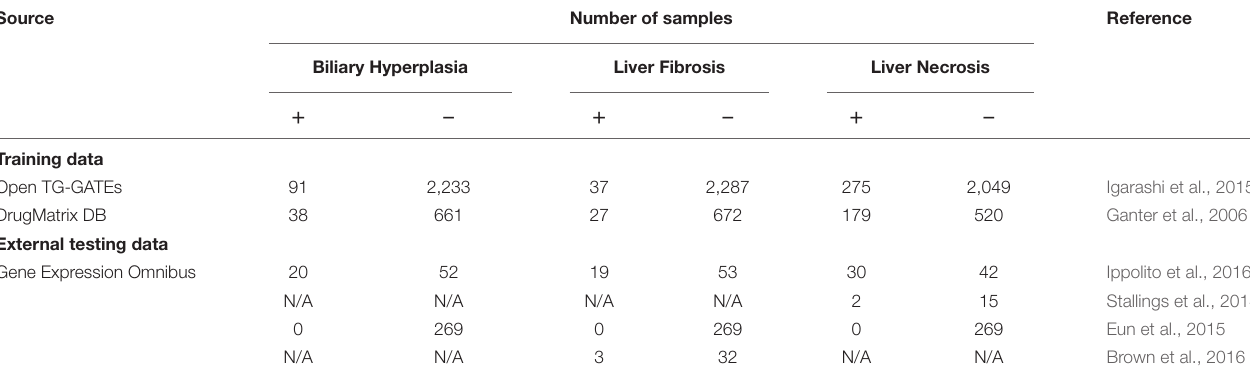
TABLE 1 | Summary of training and testing data used in this